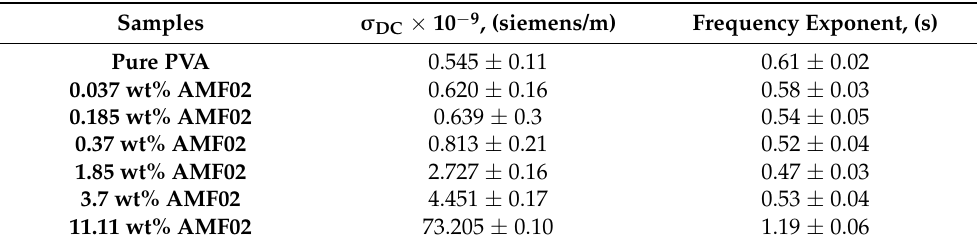
Table 3. Jonscher power law fitting parameters for pure PVA film and its AMF02 salt-doped PVA novel PCCEFs.